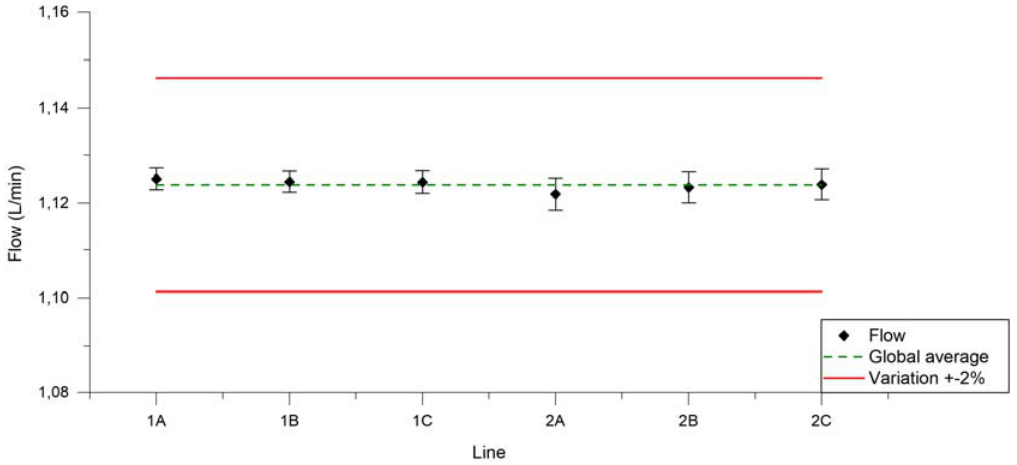
Figure 3. Average air flow rate applied from each U-SAV line over 100 puffs during 24 experiments (dark dots). Red lines represent ±2%. Green line represents the average from all U-SAV lines.